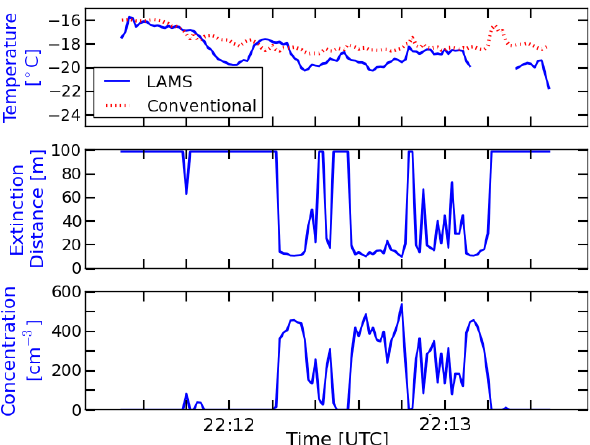
Figure 10. Top panel: temperature determined by the LAMS during a C-130 cloud pass on 15 November 2011. The temperature mea- sured by a conventional temperature probe is also shown. Middle panel: extinction length or distance corresponding to unity optical depth, determined from the measured droplet size distribution. Bot- tom panel: cloud droplet concentration measured by a cloud droplet